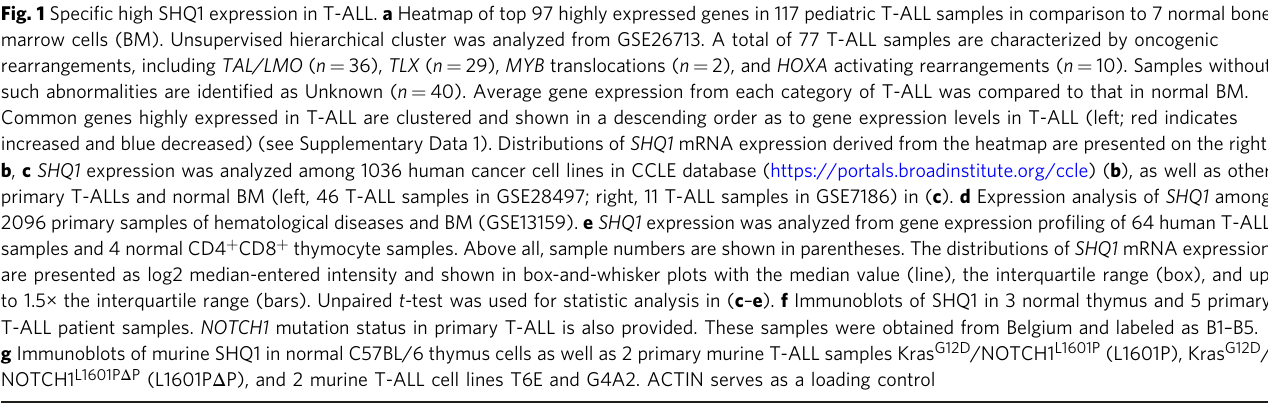
Fig. 1 Speci fi c high SHQ1 expression in T-ALL. a Heatmap of top 97 highly expressed genes in 117 pediatric T-ALL samples in comparison to 7 normal bone marrow cells (BM). Unsupervised hierarchical cluster was analyzed from GSE26713. A total of 77 T-ALL samples are characterized by oncogenic rearrangements, including TAL/LMO ( n = 36), TLX ( n = 29), MYB translocations ( n = 2), and HOXA activating rearrangements ( n = 10). Samples without such abnormalities are identi fi ed as Unknown ( n = 40). Average gene expression from each category of T-ALL was compared to that in normal BM. Common genes highly expressed in T-ALL are clustered and shown in a descending order as to gene expression levels in T-ALL (left; red indicates increased and blue decreased) (see Supplementary Data 1). Distributions of SHQ1 mRNA expression derived from the heatmap are presented on the right. b , c SHQ1 expression was analyzed among 1036 human cancer cell lines in CCLE database (https://portals.broadinstitute.org/ccle) ( b ), as well as other primary T-ALLs and normal BM (left, 46 T-ALL samples in GSE28497; right, 11 T-ALL samples in GSE7186) in ( c ). d Expression analysis of SHQ1